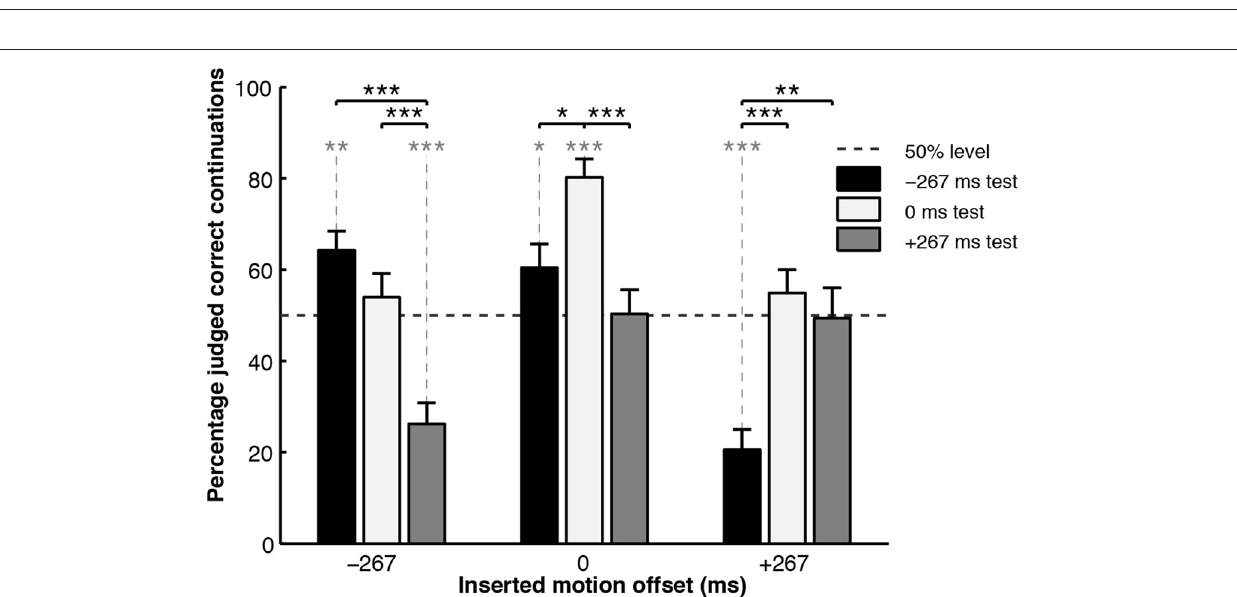
FIGURE 4 | Percentage correct judgments for the “inserted motion” experiment. Black asterisks connected with solid lines indicate significance levels of between-condition t -test comparisons. Asterisks in gray connected with dotted lines indicate significance levels of one-sample